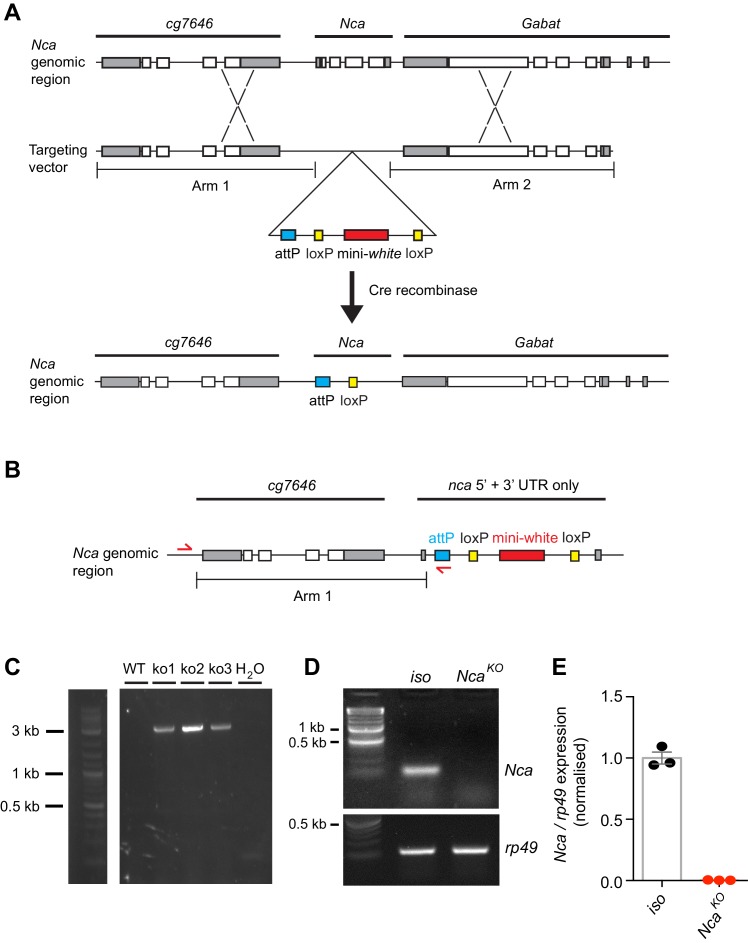
Generation of Nca null alleles using ends-out homologous recombination.(A) Schematic illustration of the procedure used to generate Nca knockout alleles. Homologous arms upstream (Arm 1) and downstream (Arm 2) of the Nca locus are indicated. Upstream 5’ promoter regions shared by the cg7646 and Nca loci (see Figure 1—figure supplement 2A) are external to the homologous arm sequences and are not shown. Following homologous recombination, the endogenous Nca locus is replaced by a cassette containing the mini-white selection marker (red bar), and attP (blue bar) and loxP sites (yellow bars). The mini-white cassette was subsequently removed via Cre-loxP recombination. (B–C) PCR validation of homologous recombination events. Correct recombination was verified using primers designed to the attP site and upstream of the cg7646 coding regions (B), which will only generate a ~ 3 kb product following homologous recombination between the targeting vector and the Nca locus (C). Three independent targeting events (ko1-3) were validated by genomic PCR. WT: wild-type genome lacking an attP site 3’of cg7646. (D–E) No Nca mRNA was detected in NcaKO1 using either standard RT-PCR (D) or quantitative RT-PCR (E; n = 3 qPCR reactions for iso31 control and NcaKO1 flies).